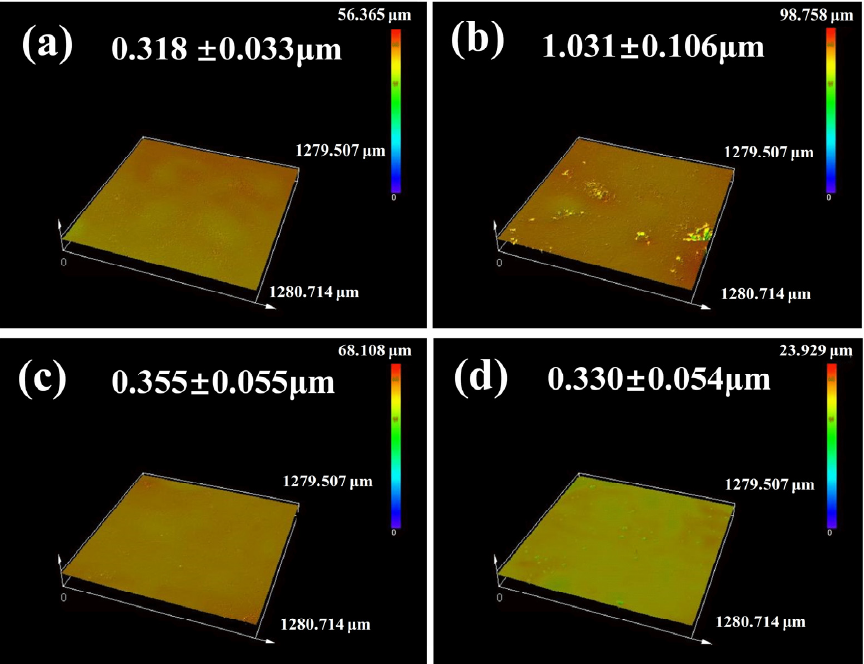
Figure 11. The 3D morphology and roughness (arithmetical mean height) of different coating samples ( a ) blank epoxy coating ( b ) epoxy coating with 2 wt.% MgAl-LDH ( c ) epoxy coating with 2 wt.% ZnAl-LDH ( d ) epoxy coating with 2 wt.% CaAl-LDH.